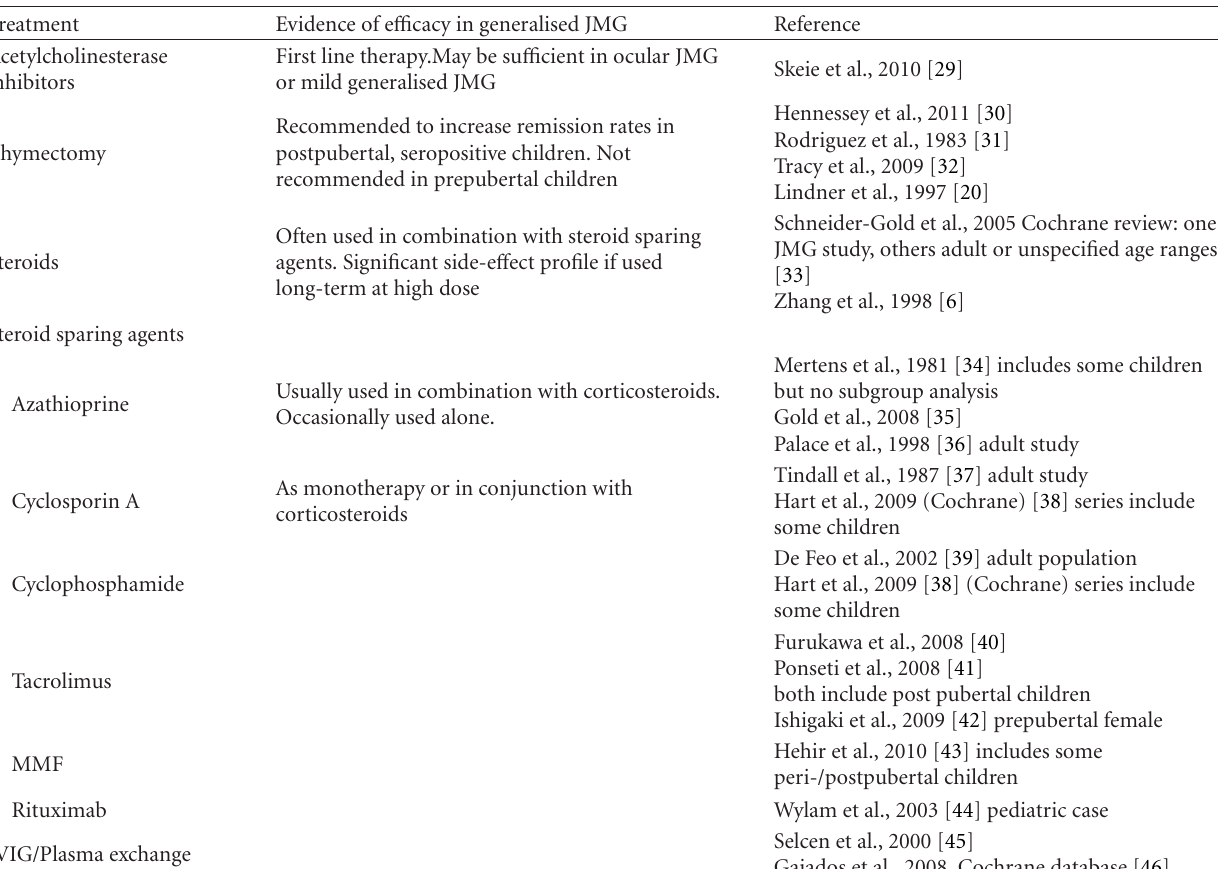
Table 3: Treatment options in